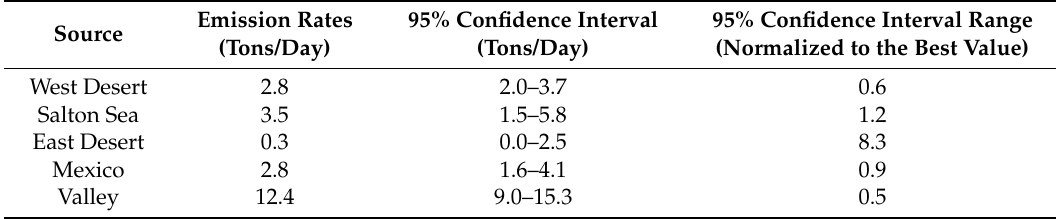
Table 1. Emission rates calculated by the model for annually averaged data.